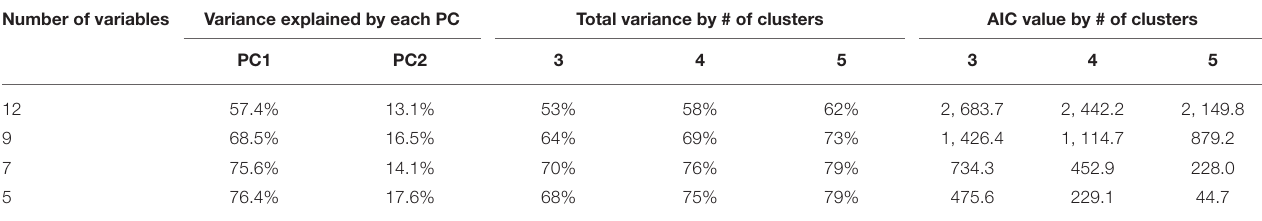
TABLE 3 | Selection of clusters based on variance explained and model-fit. Number of variables Variance explained by each PC Total variance by # of